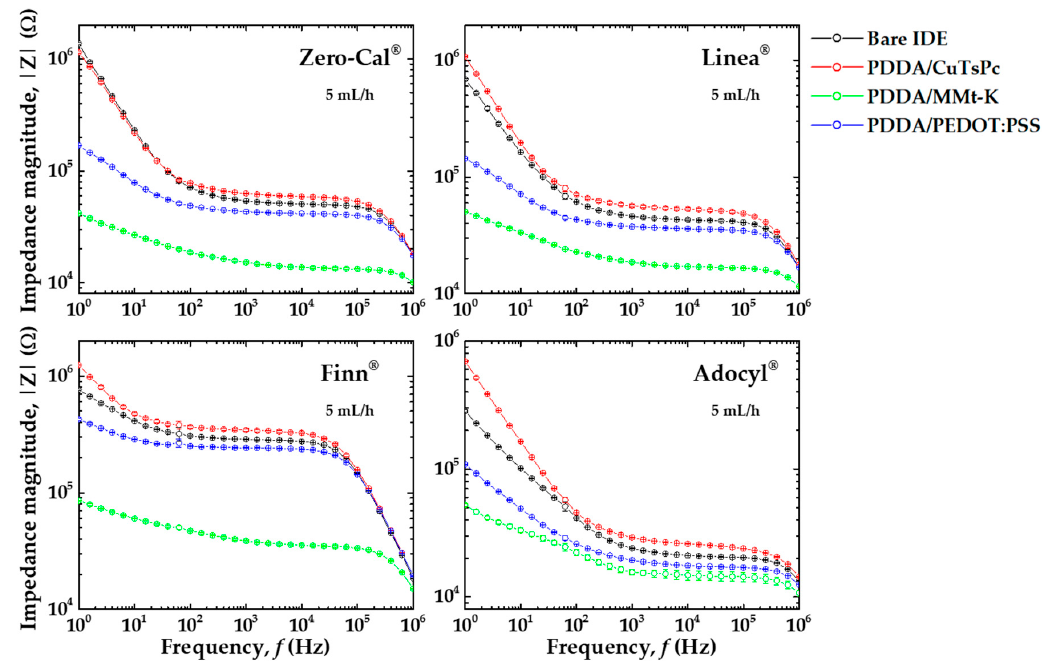
Figure 6. Impedance magnitude versus frequency spectra measured with the collinear sensing units (bare IDE, PDDA/CuTsPc, PDDA/MMt-K, and PDDA/PEDOT:PSS) in a single microchannel for the sucralose-based sweeteners of distinct brands (Zero-Cal ® , Linea ® , Finn ® , and Adocyl ® ) in aqueous solutions (10 µL/mL) at 5 mL/h flow rate.